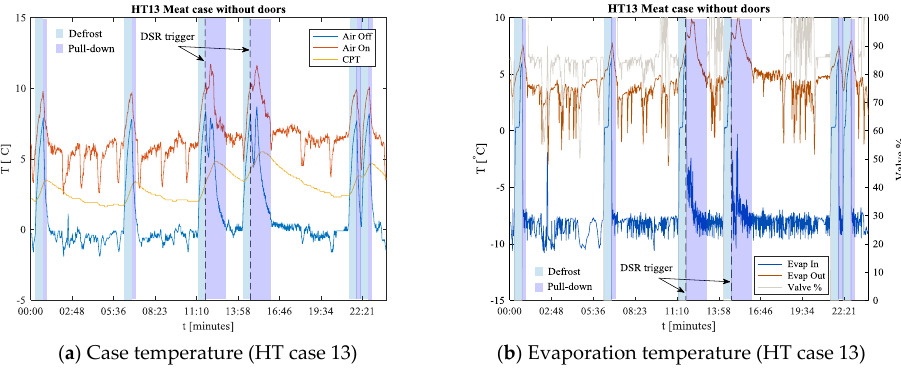
Figure 7. Evaporation temperature increase. Case 13 is not recovering from both defrosts after triggered DSRs.